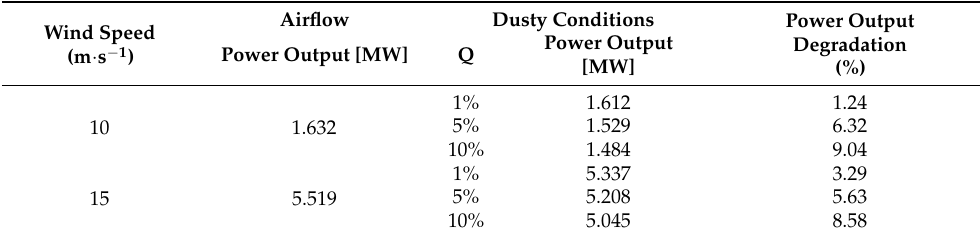
Table 7. Power output of present model in clean air flow and in dusty environment and its percentage